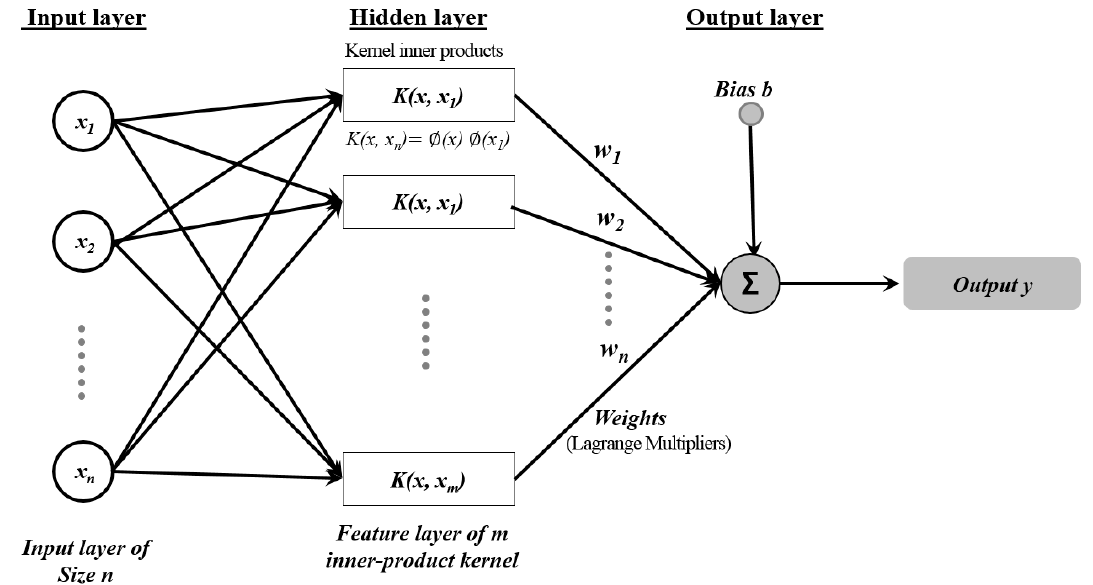
Figure 3. Schematic architecture of the SVM based on a radial basis functions (RBF) network.